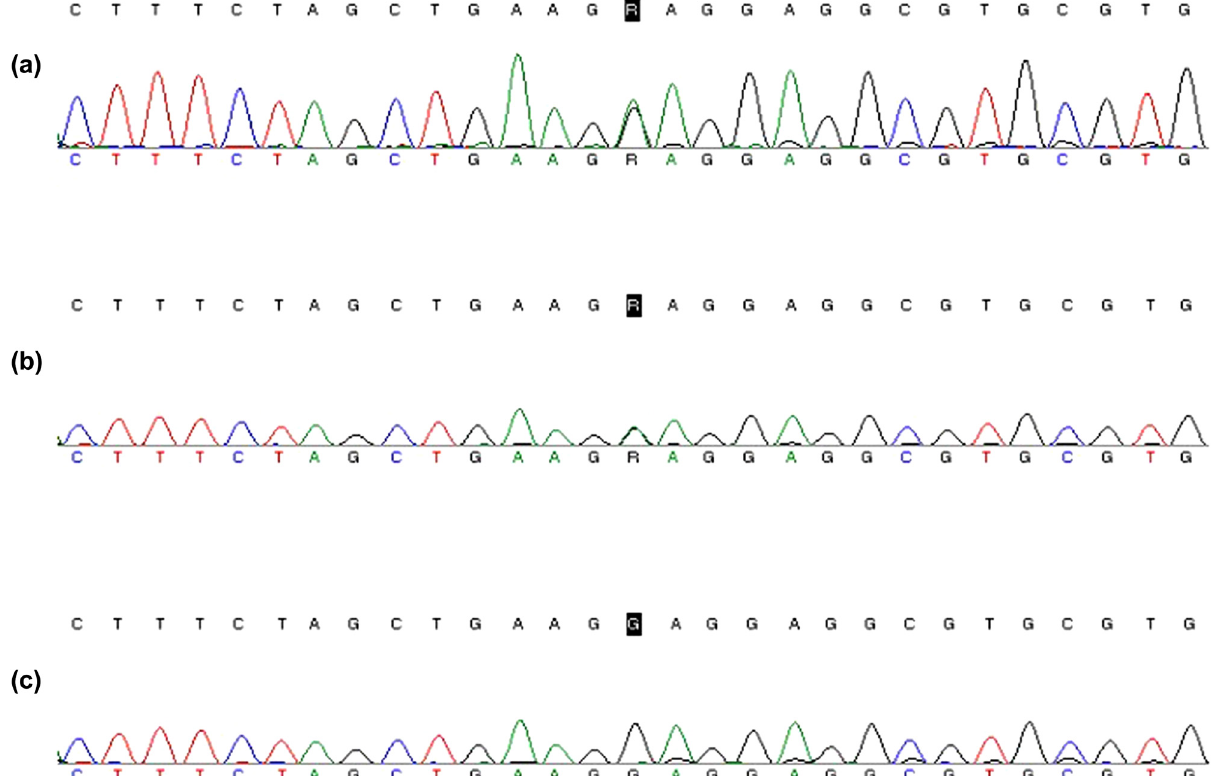
Figure 2: Sanger Sequencing Peak Map. ( a ) Proband ( III 1 ) FGA gene sequencing results; ( b ) proband ’ s father ( II 1 ) FGA gene sequencing results; and ( c ) proband ’ s mother ( II 2 ) FGA gene sequencing